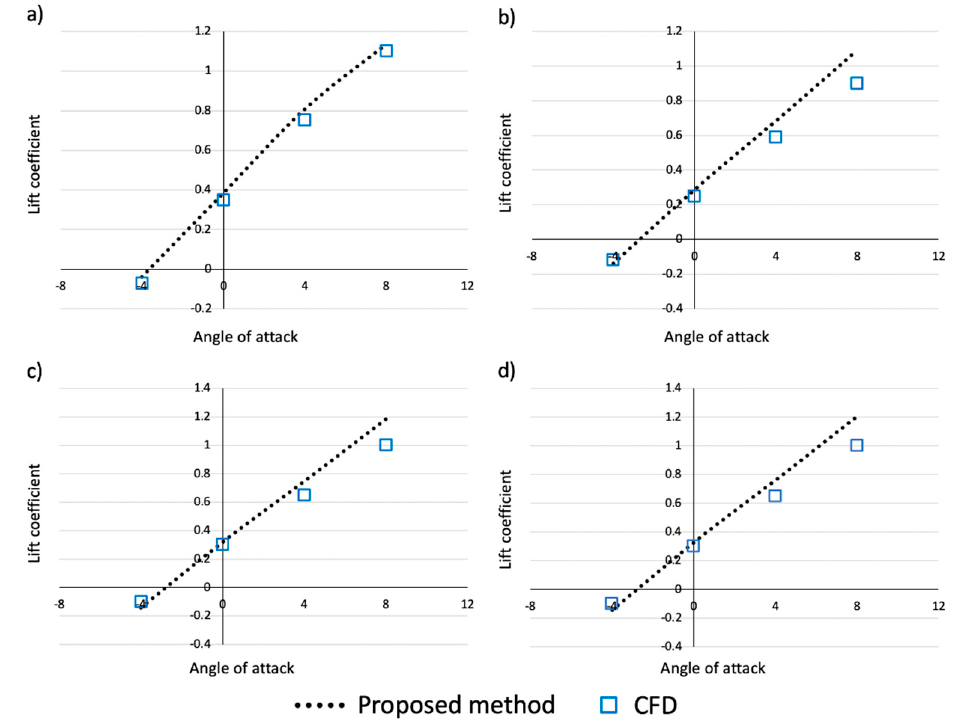
Figure 16. Lift coefficient comparison, for configurations ( a – d ).